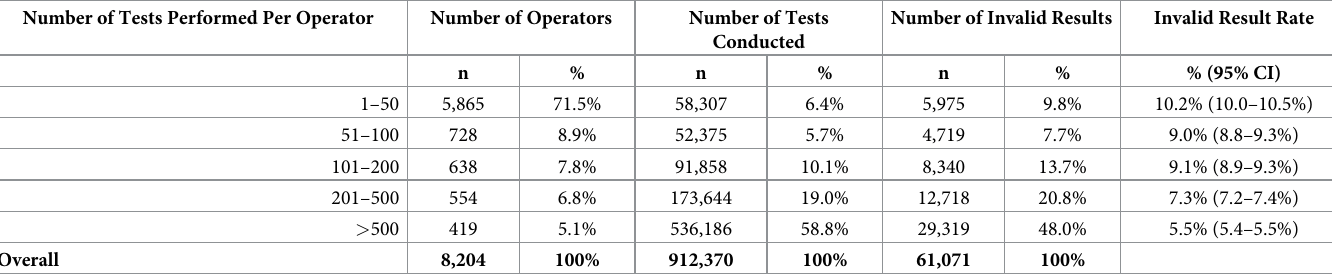
Table 4. Total tests run and invalid results and rates by operator testing volume. Number of Tests Performed Per Operator